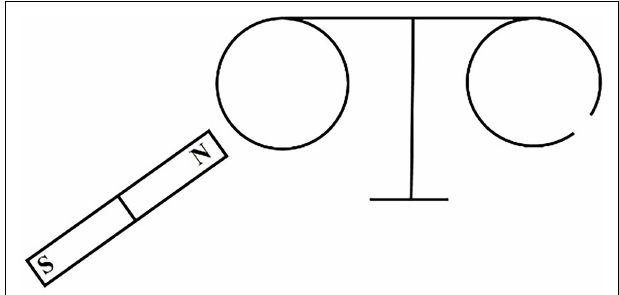
FIGURE 6 | Experimental circuit ii of EIP = 0 level remedial teaching scheme.